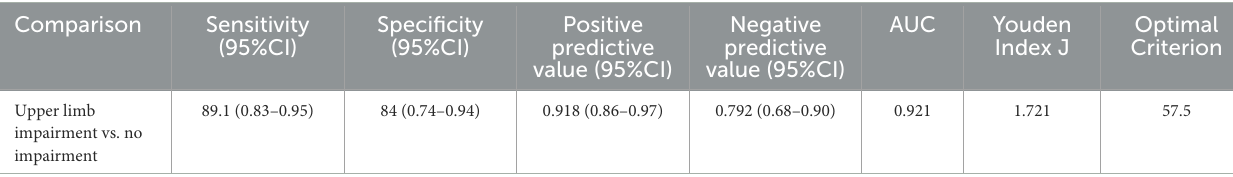
TABLE 8 Value of area under the receiver operating characteristic curve, sensitivity, and specificity for the optimal cut-offs of C-UEFI ( N = 101).